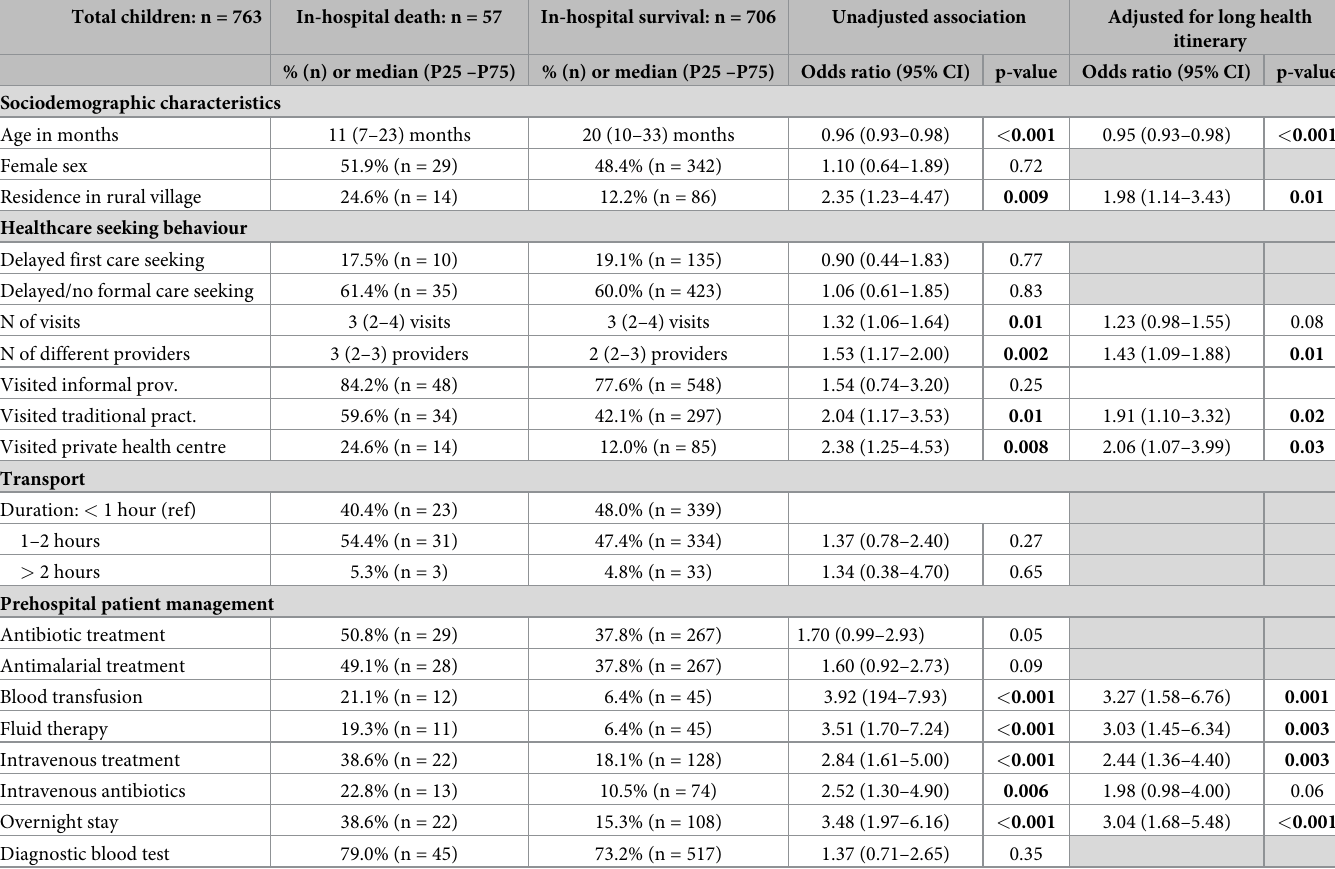
Table 2. Association between in-hospital death and sociodemographic characteristics or factors that are significantly associated with a long health itinerary (see Table 1), calculated by logistic regression. First the unadjusted association was calculated. Next, significant unadjusted associations were adjusted for long health itiner- ary with multivariable logistic